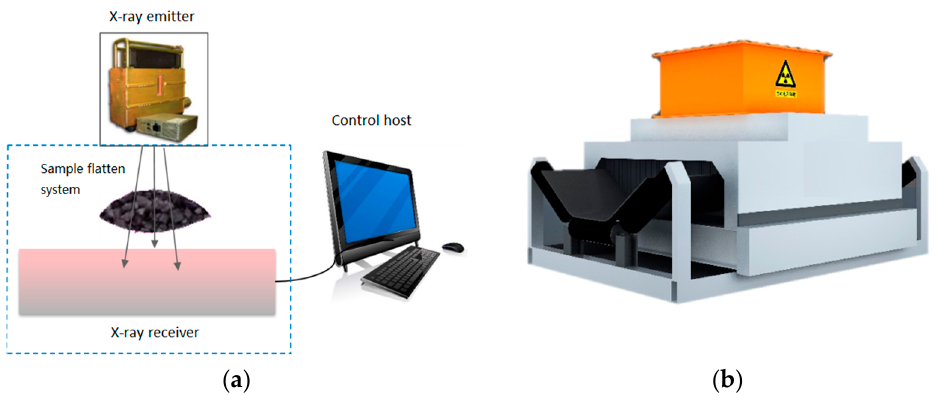
Figure 2. Experimental system of the X-ray ash content analyzer. ( a ) The schematic of X-ray ash content analyzer, ( b ) Experimental system of the X-ray ash content analyzer.